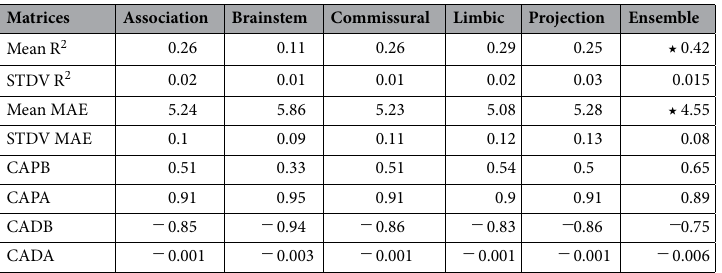
Table 1. Performance of the five FG-based models plus the Ensemble one to estimate brain age in terms 2 of MAE and R . The last four rows provide the CAPB, CAPA, CADB and CADA, respectively. The best performing model is identified by star symbol.